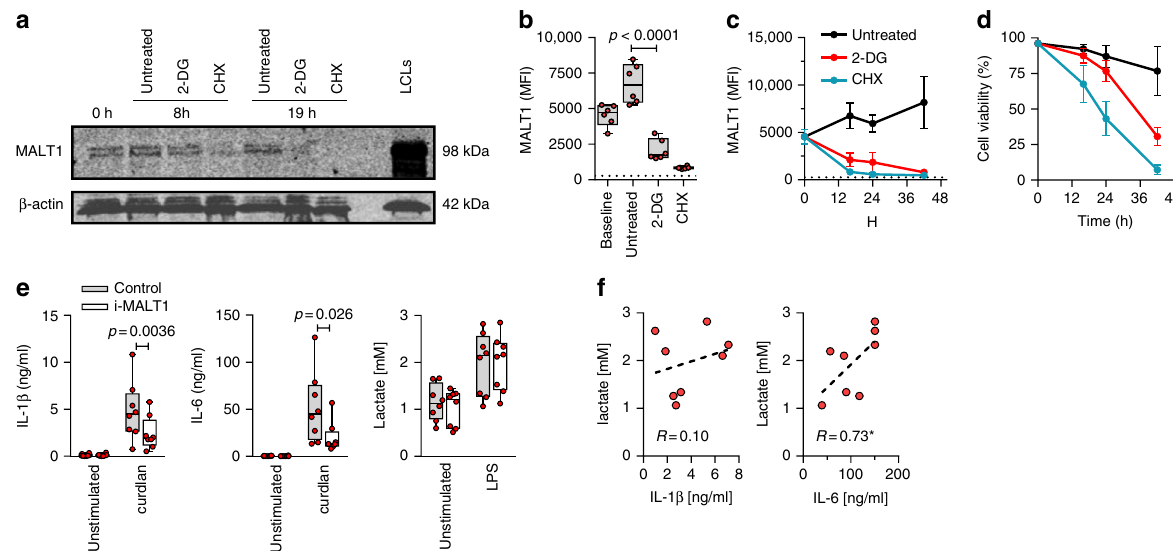
Fig. 8 Inhibition glycolysis results in loss of MALT1 protein expression. Effect of blocking glycolysis (using 2-DG) or of blocking translation (using cycloheximide, as control) on MALT1 protein expression (monocytes). a MALT1 protein was detected by Western blot (left panel; representative of two experiments; cropped images from same blot probed with each antibody) at 8 h and 19 h. Lymphoblastoid cell line (LCL) lysate used as positive control for MALT1 protein expression; MALT1 protein detection ( b ) at 16 h and ( c ) over time (intracellular staining by fl ow cytometry, gated on CD14-expressing cells; MFI mean fl uorescence intensity; dotted line: signal for fl uorescence-minus-one staining control MFI level; boxes and whiskers with a paired 2-sided t -test in b ; mean ± SD in c and d ; d corresponding cell viability over time (mean ± SD); 6 subjects. e Effect of MALT1 inhibition on IL-1 β , IL-6, and lactate production at rest and following LPS (mononuclear cells; boxes and whiskers with 2-sided paired t -tests); f correlation between LPS-induced IL-1 β and IL-6, and lactate production (Spearman ’ r ; * p < 0.05; with dotted regression line); 8 subjects. All experiments were conducted in adult